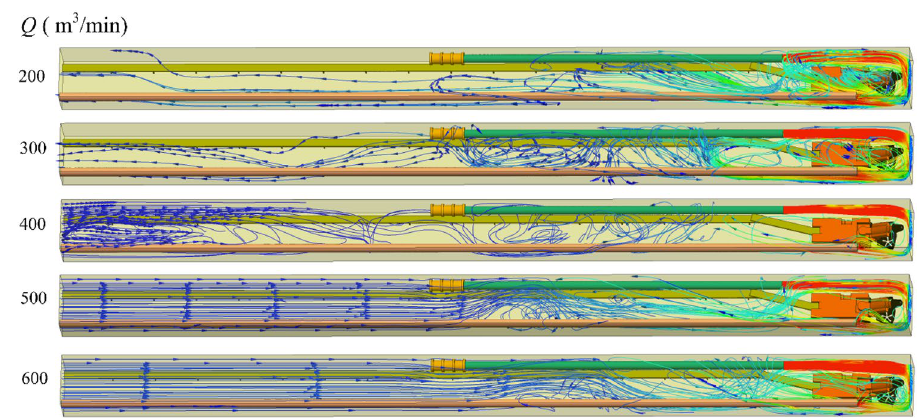
Figure 3. Downdraught flow diagram of air volume Q of different suction